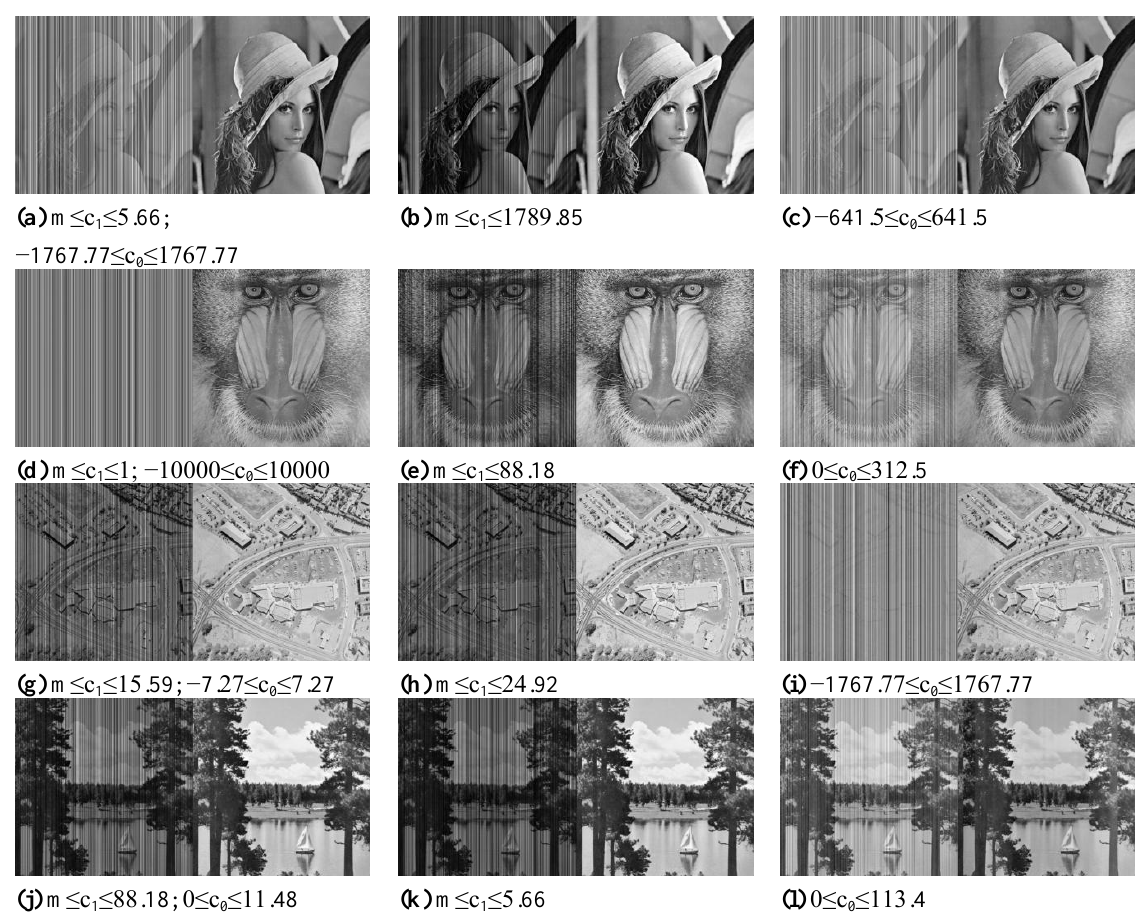
Figure 5. Exemplary striped grey scaled images (left) and destriping results (right) for slope c and offset c (a,d,g,j), slope c (b,e,h,k) and offset c 1 0 1